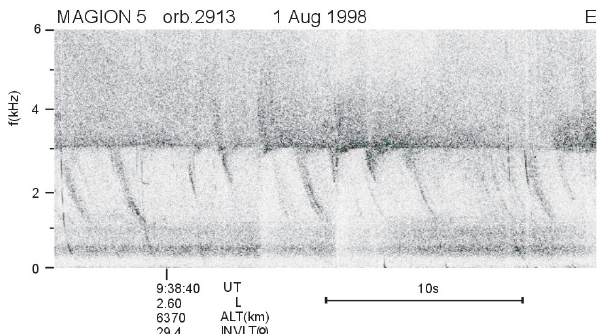
Fig. 7. 28 second interval from electric field registrations shown in the top panel of Fig. 5. A relationship between LHR noise and nonducted whistler mode waves is evident.